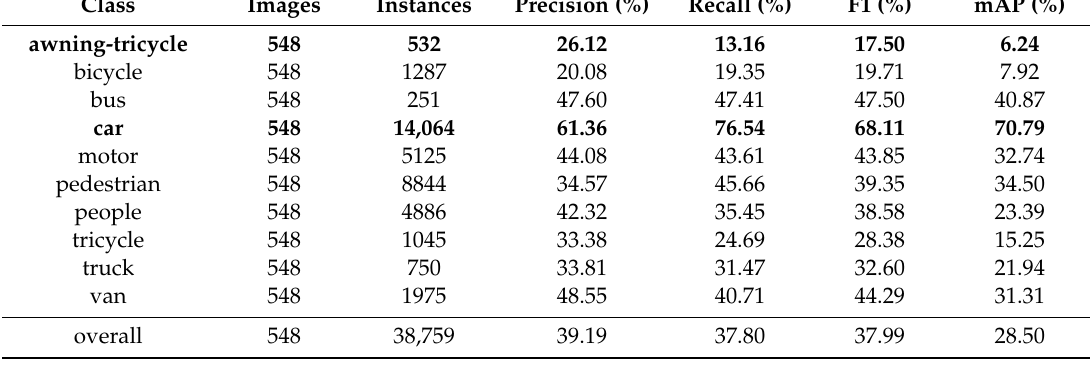
Table 8. Detection performance of Mixed YOLOv3-LITE (832 × 832) for each category using VisDrone2018-Det validation dataset.